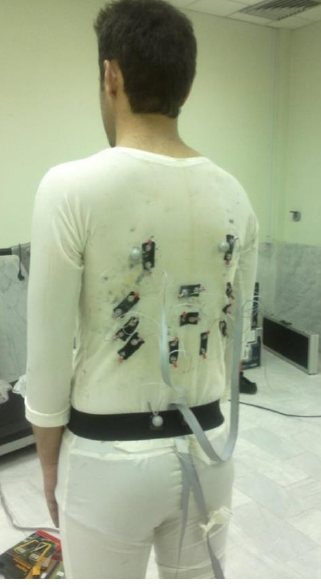
Figure 6. The final determined positions of the BWSs on clothing as manufactured. The clothing was fixed by a belt on the hip. fixed by a belt on the hip.